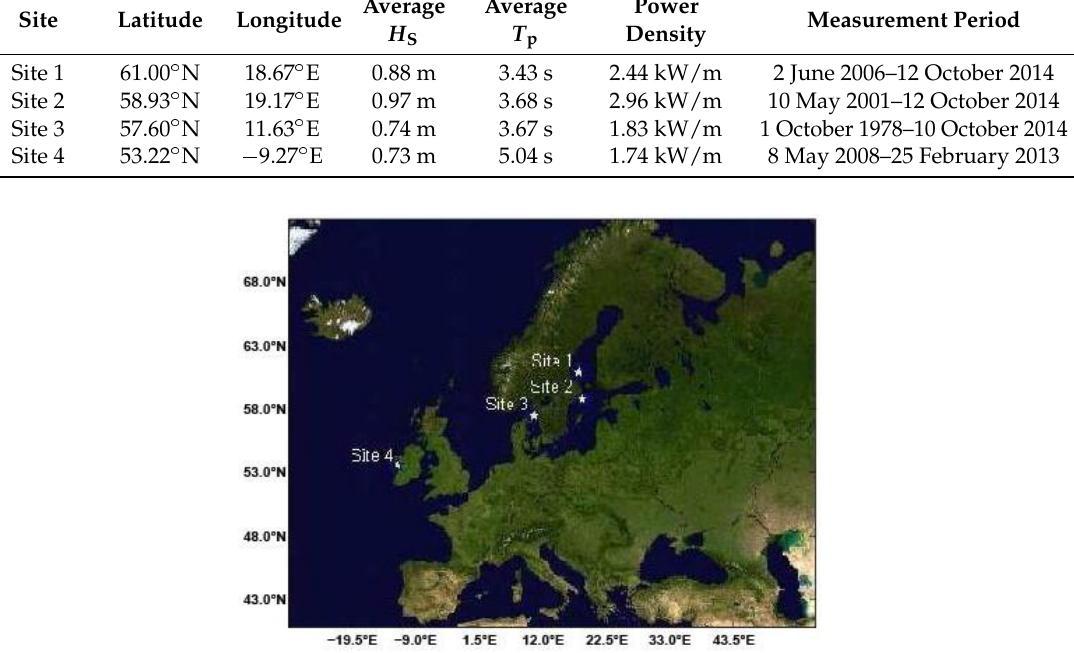
Table 4. Information of the wave data for the four chosen sites.